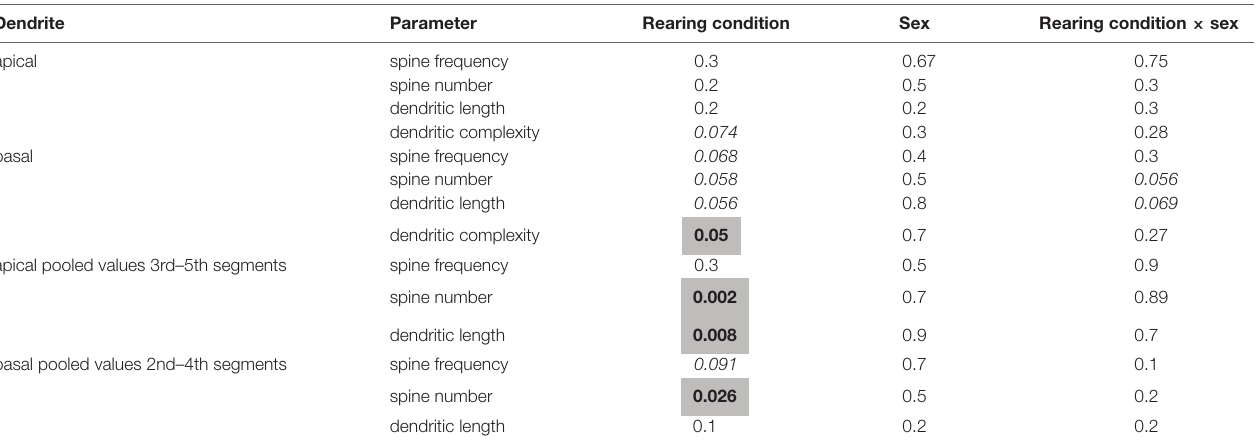
TABLE 1 | Results of two-way ANOVA for factors rearing, sex, and interaction of rearing condition × sex.